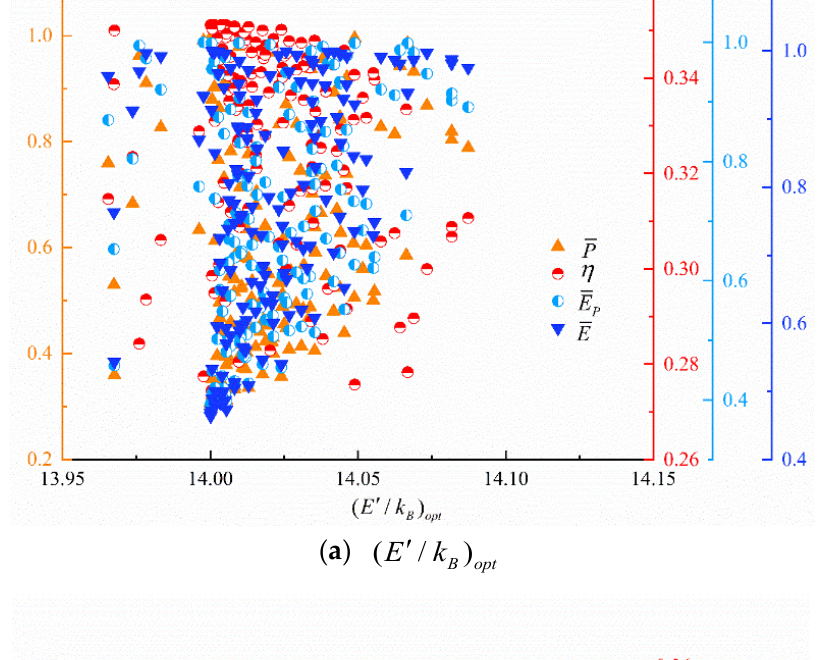
7 of 19 Figure 3. Pareto frontier with